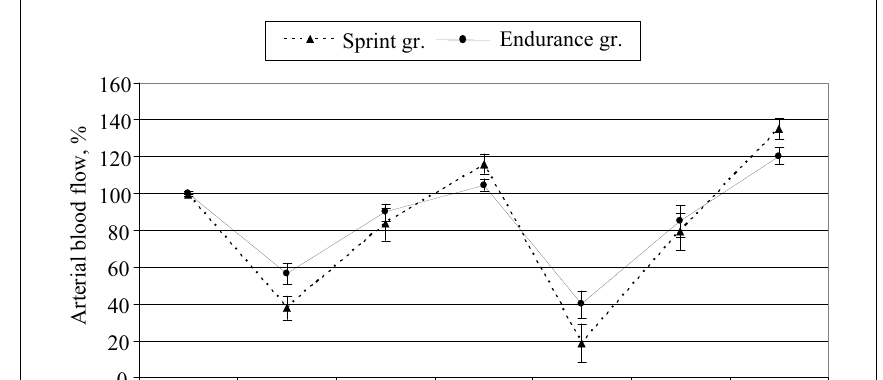
Figure 3. Dynamics of StO 2 during dosed and maximal exercise test